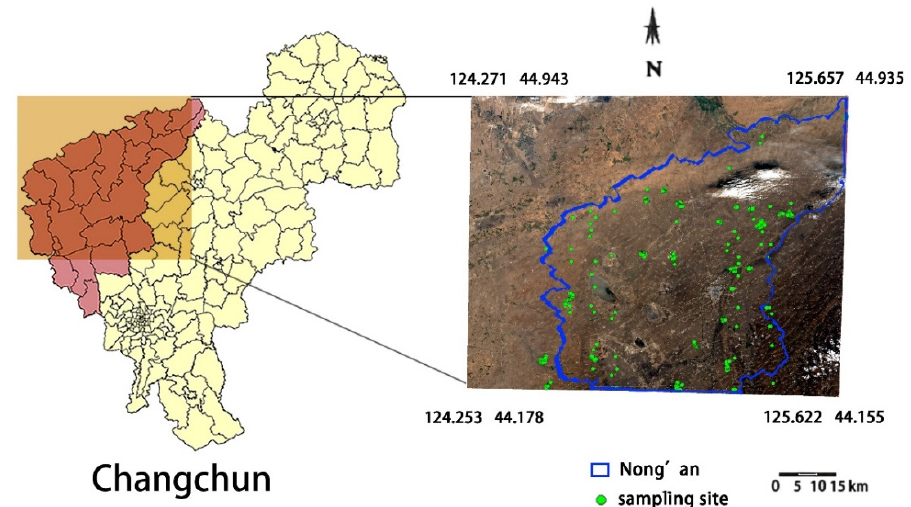
Figure 1. Distribution of soil sampling sites in the study area (the blue area refers to the administrative district of Nong’an County).